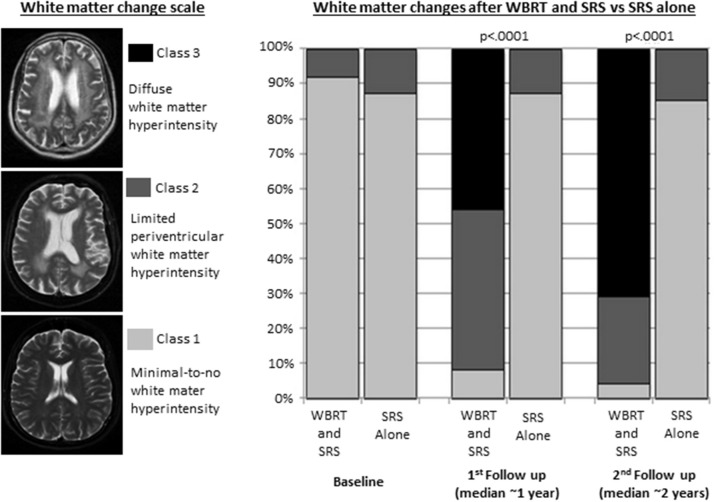
White matter changes in patients with non-small cell lung cancer brain metastases treated with whole brain radiation therapy (WBRT) and stereotactic radiosurgery (SRS) (n = 37) or SRS alone (n = 31). Adapted from Monaco et al. (39) with permission from the publisher.